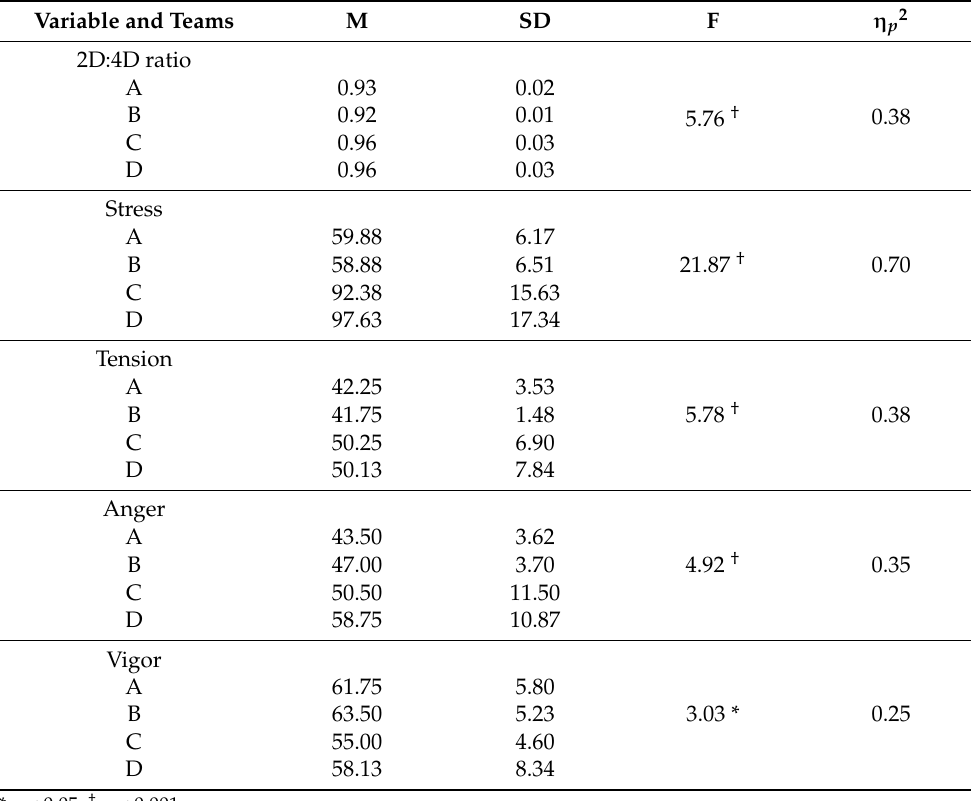
Table 3. Analysis of Variance (ANOVA) Results.